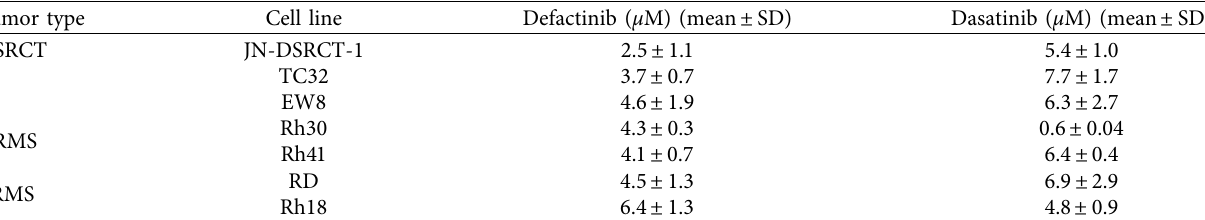
Table 3: IC 50 value defactinib and dasatinib in DSRCT, ES, and RMS cell lines. Tumor